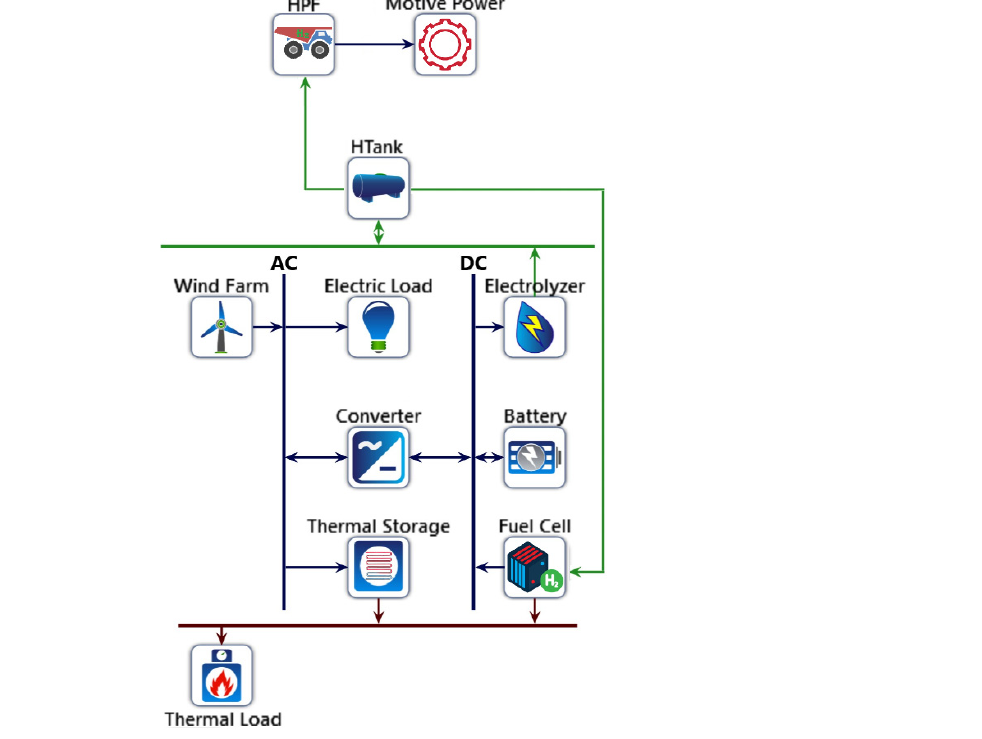
Figure 3. All-renewable system with hydrogen-powered fleet (HPF) and battery/fc (fuel cell) storage configuration.